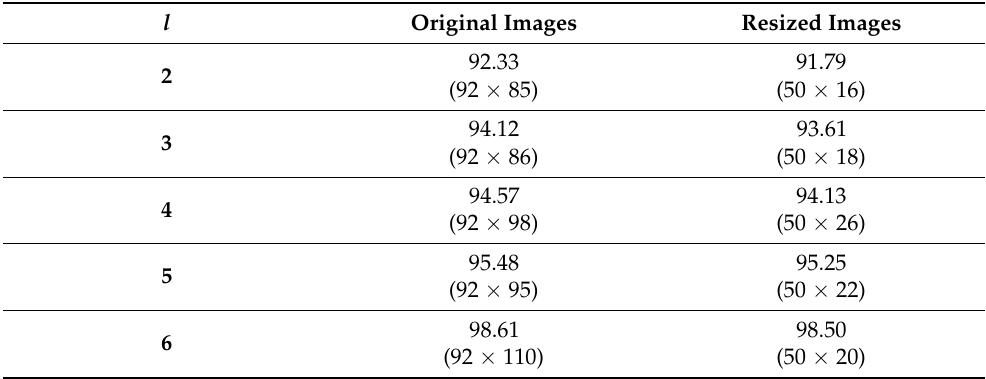
Table 1. Max accuracy (%) of 2DESDLPP experimenting on original images and resized images, and the corresponding number of dimensions in the ORL